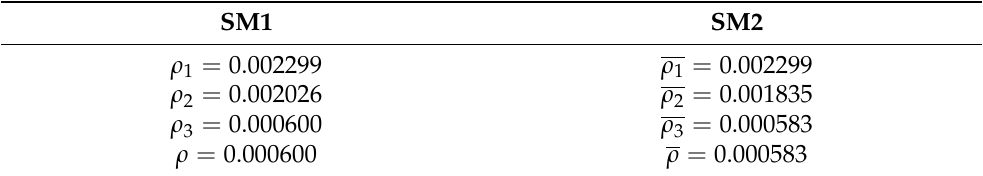
Table 3. Comparison of convergence radii for Example